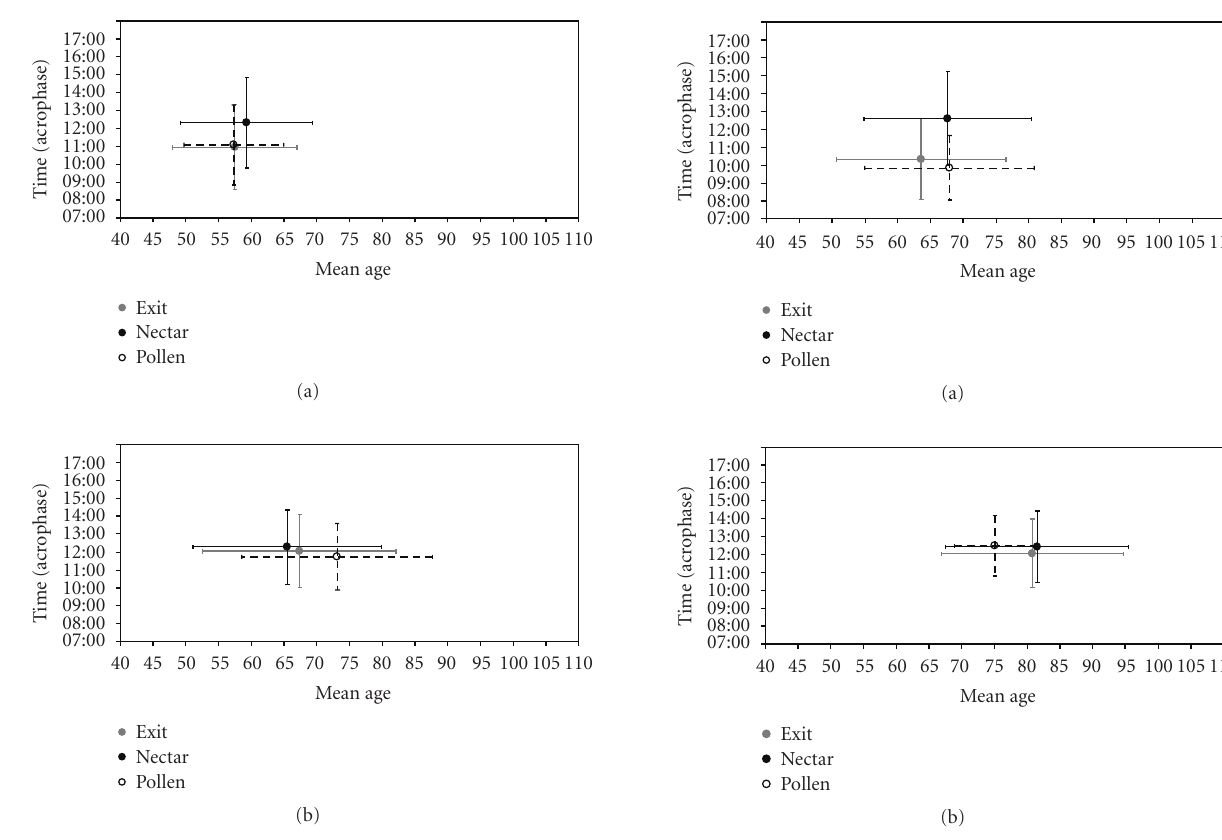
Figure 9: Acrophases with their respectives angular deviations ( y axis) and mean ages with their respectives standard deviations ( x axis) of nectar and pollen foraging and exit of marked bees of colony 2 of Plebeia remota , in the reproductive phase (a) and reproductive diapause